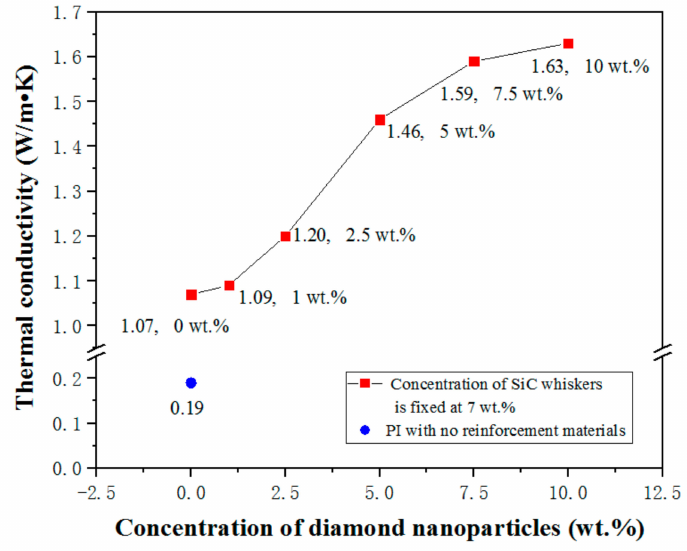
Figure 6. Thermal conductivity of the composite versus di ff erent DN